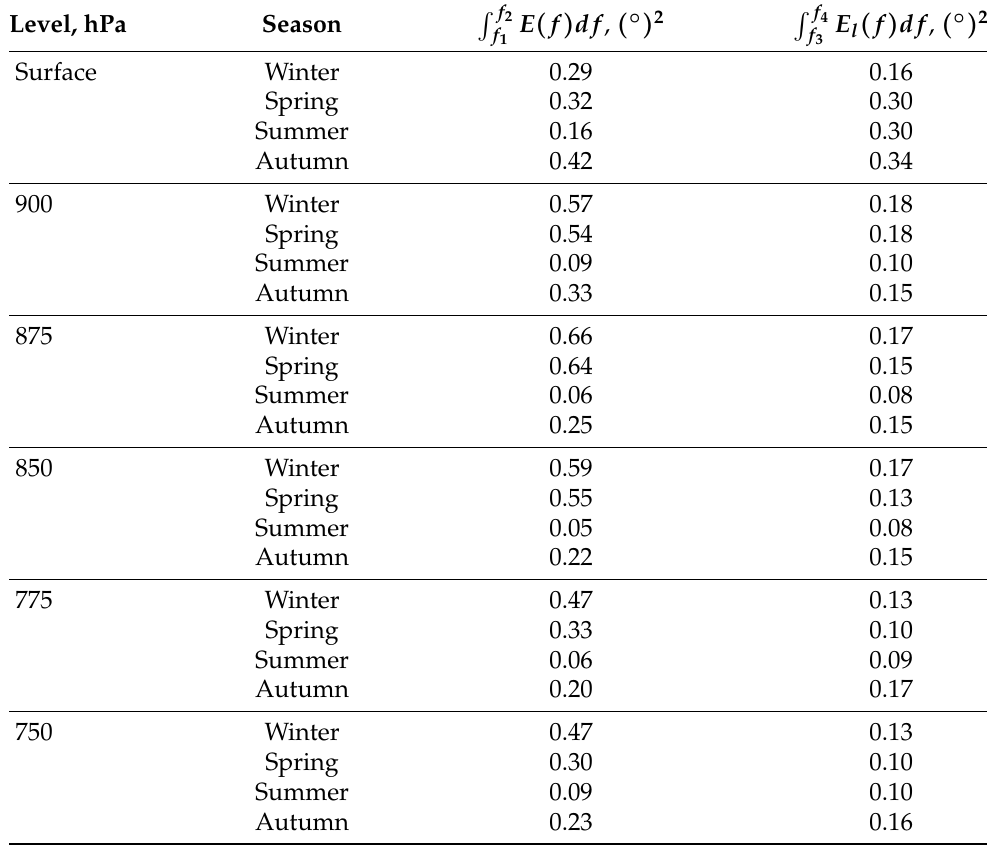
(cid:82) f 2 (cid:82) f 4 E ( f ) df and E l ( f ) df at the Nha Trang observatory. f 1 f 3